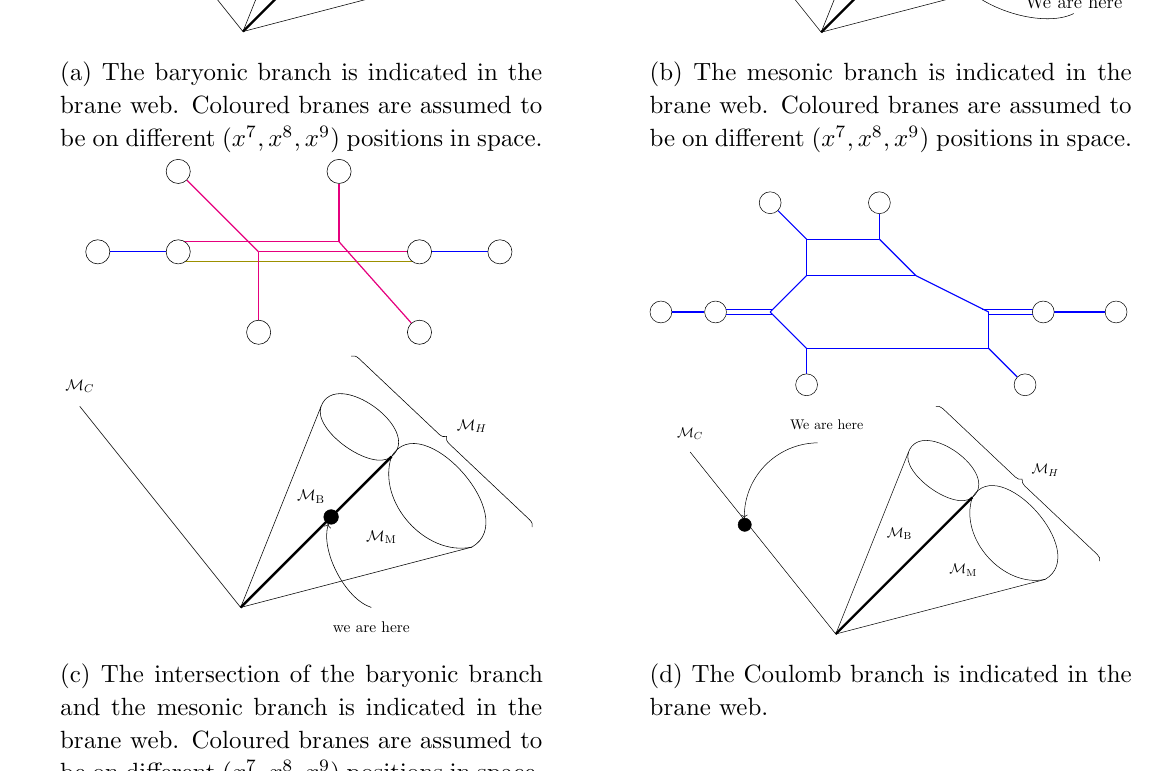
(d) The Coulomb branch is indicated in the brane web.